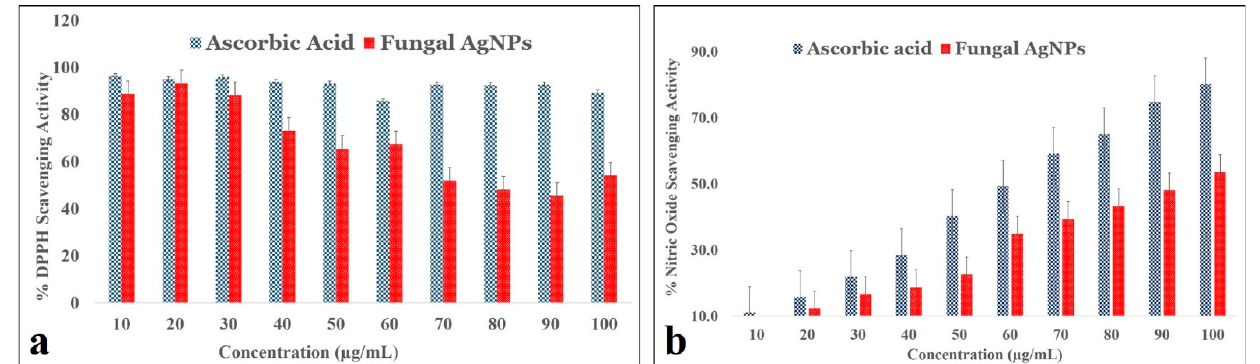
Figure 8. Antioxidant activity of T. funiculosus –AgNPs in terms of radical scavenging activity: ( a ) DPPH scavenging activity, ( b ) nitric oxide scavenging activity. Error bars represent standard devi- ation of the mean. Significant difference ( p ≤ 0.05).